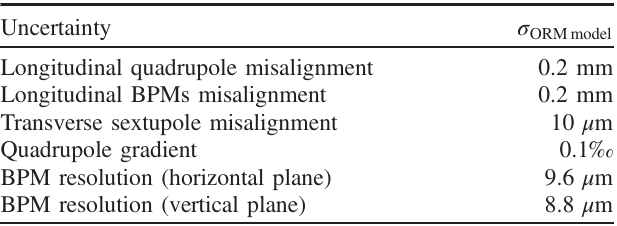
TABLE I. Estimated Gaussian uncertainties of the ESRF lattice using the ORM inferred model.